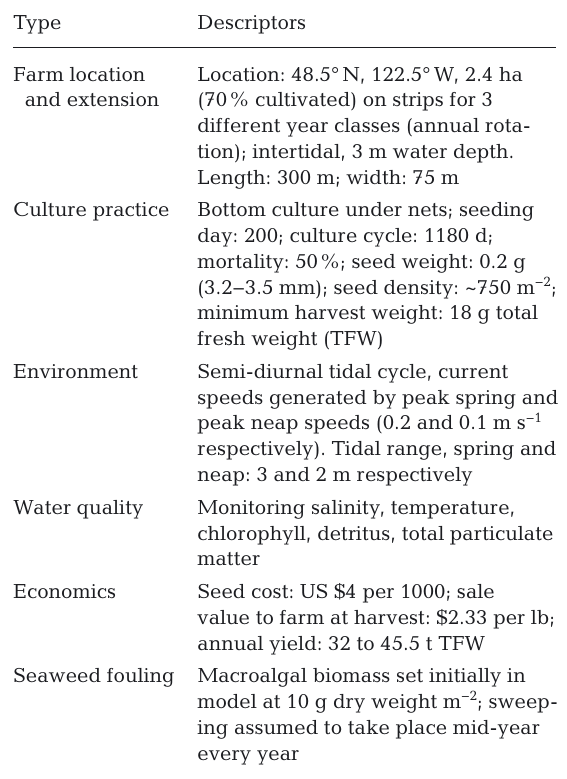
Table 1. Culture practice for Chuckanut Shellfish